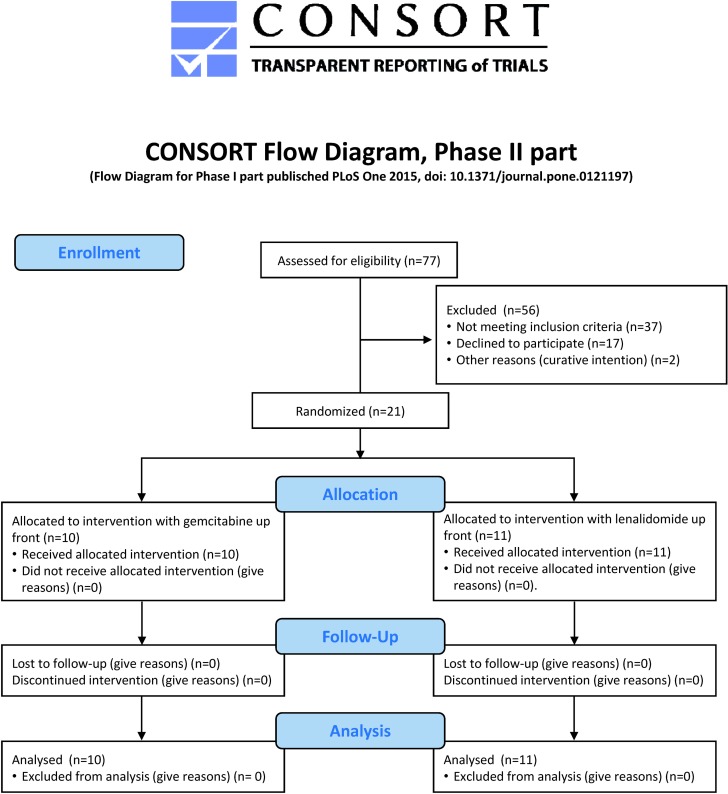
CONSORT Flow Diagram for the patients screened for and enrolled in part II.Corresponding data for patients enrolled in part I, has been published in Ullenhag GJ et al, PLOS ONE, 2015; 10(4).